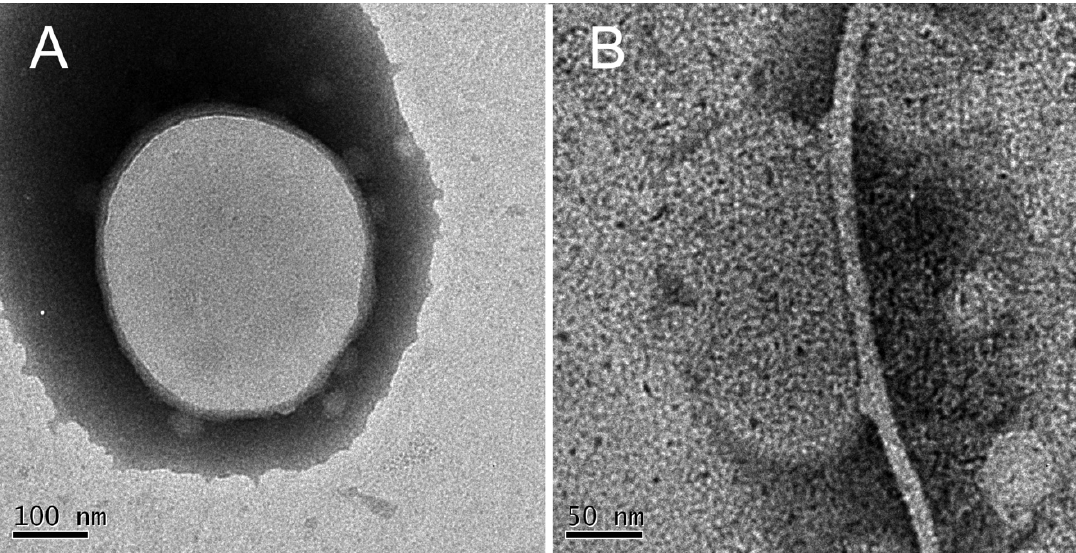
Figure 11. EF-TEM micrograph representing a liposome incorporating GM1 and Chol mimicking “lipid-rafts” interacting with PFs (solution T13; A ) and with a long and thin MFs (solution T20; B ) without membrane disruption or internalization.